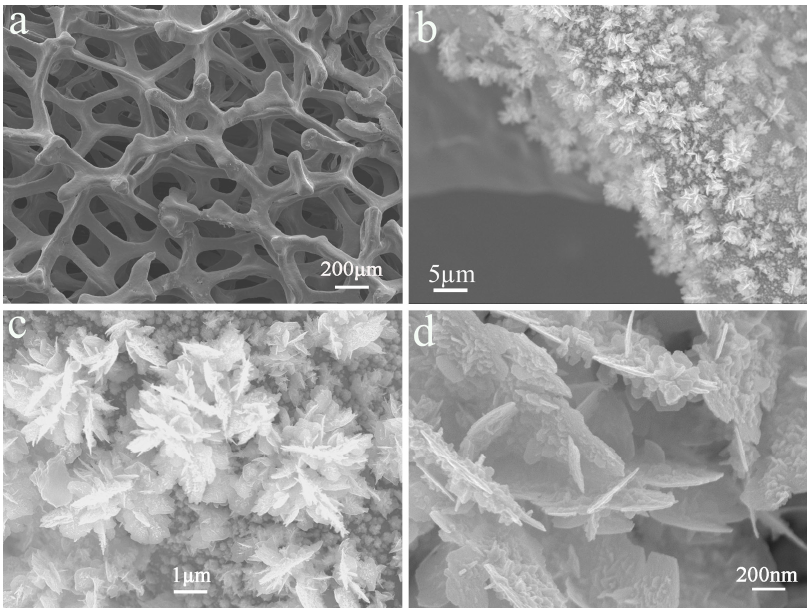
Figure 1. FE-SEM images: ( a ) pristine nickel foam; ( b – d ) Ag nanoflowers at different magnifications. Crystals 2019 , 9 , x FOR PEER REVIEW